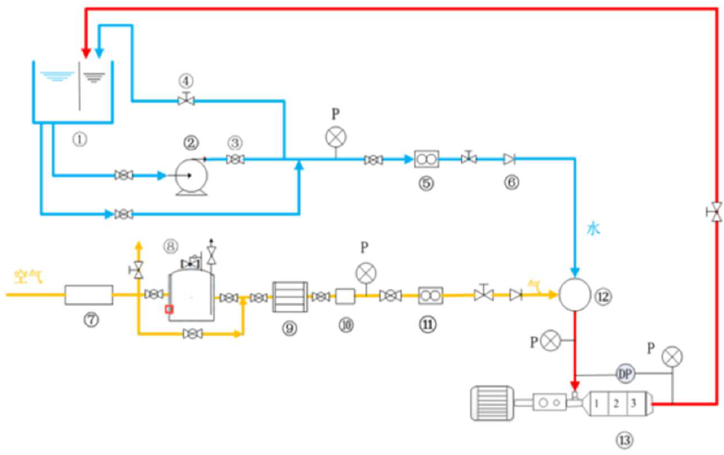
Figure 15. Experimental system principle scheme. ( 1 ) Tank; ( 2 ) Plunger pump; ( 3 , 4 ) Valves; ( 5 , 11 ) Flowmeter; ( 6 ) Check valve; ( 7 ) Air compressor; ( 8 ) Gasholder; ( 9 ) Air dryer; ( 10 ) Filter; ( 12 ) Commingler; ( 13 ) Pump Test section. Label: P: Pressure sensor; DP: Differential pressure sensor.